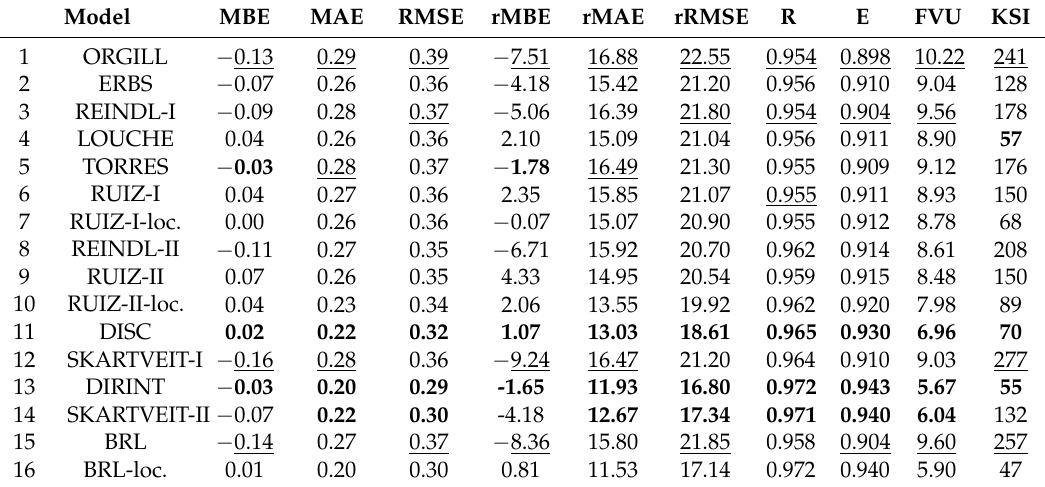
Table 4. As in Table 3, but for hourly DNI values. Relative errors are calculated with respect to the overall mean value of DNI (1.71 MJ m − 2